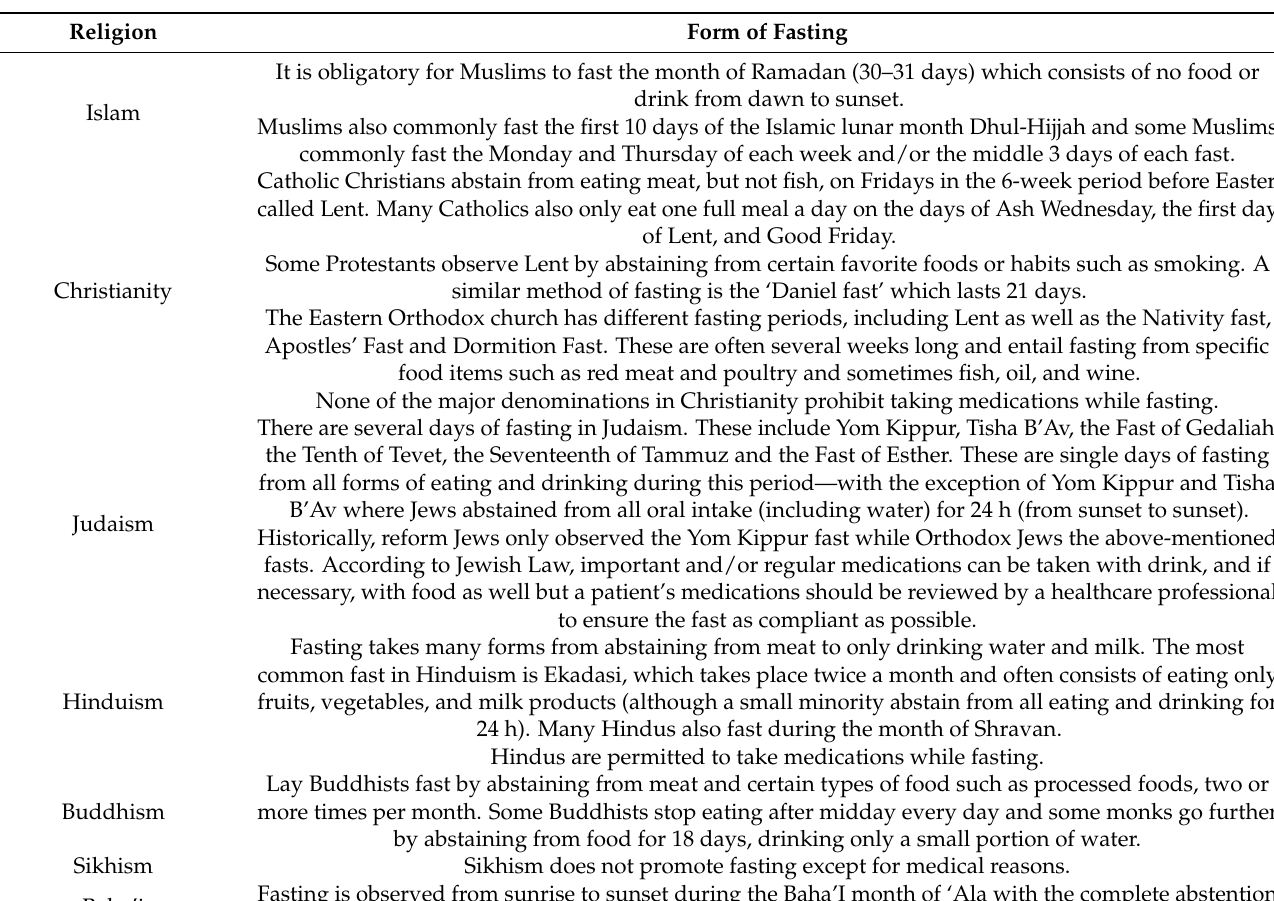
Table 2. Summary of the different fasting practices in major world religions. Form of